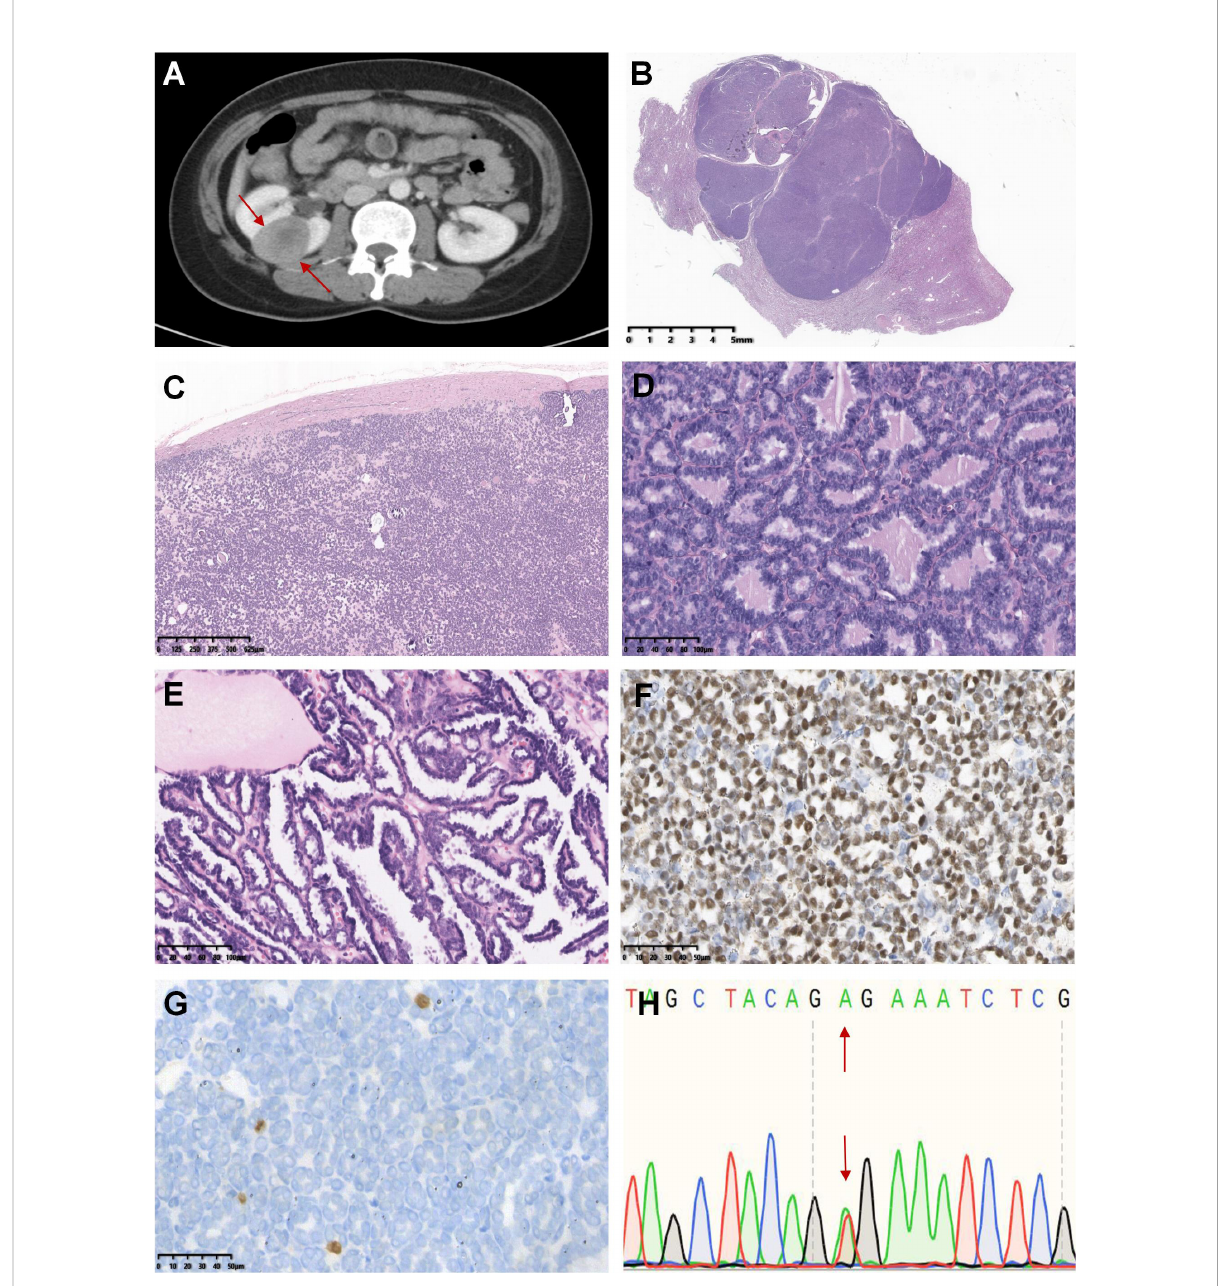
FIGURE 1 Case 1-20 demonstrated the typical histomorphological spectrum of MA. The representative morphological images were shown below: Axial computer tomography scan displayed a soft tissue mass of 3.1 cm × 3.7 cm in the upper pole of the right kidney, with a clear boundary and obvious enhancement (case 2, A ). The tumor was multinodular, well-de fi ned and usually abutted directly against the normal renal tissue without a pseudocapsule (case 18, B ). Psammoma bodies were common and may be numerous, and the stroma ranged from inconspicuous to loose and edematous (case 16, C ). Tumors were highly cellular and composed of crowded small, round acini, papillae or antler tubular structures, and mitotic fi gures were rare or absent (case 19 and 7, D, E ). Tumor cells showed diffusely positive staining for WT1 (case 7, F ) but negative expression or only a few cells expressed Ki-67 (case 7, G ). Sanger sequencing revealed that the tumor harbored the T1799A mutation in exon 15 of the BRAF gene (V600E mutation) (case 7, H